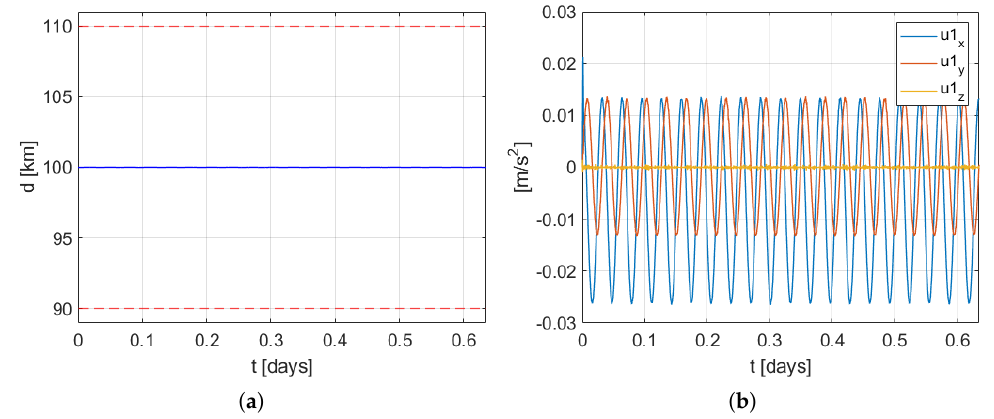
Figure 5. MPC formation control using TD model. ( a ) Inter-satellite distance. ( b ) Commands requested by MPC.